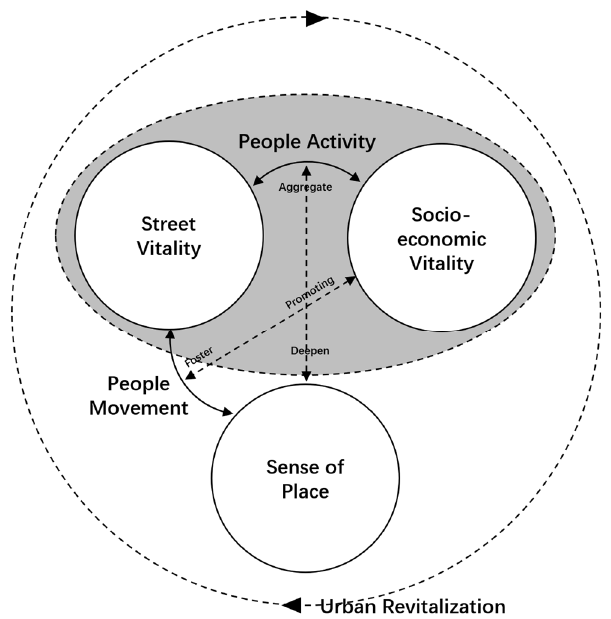
Figure 1. The circle of Street